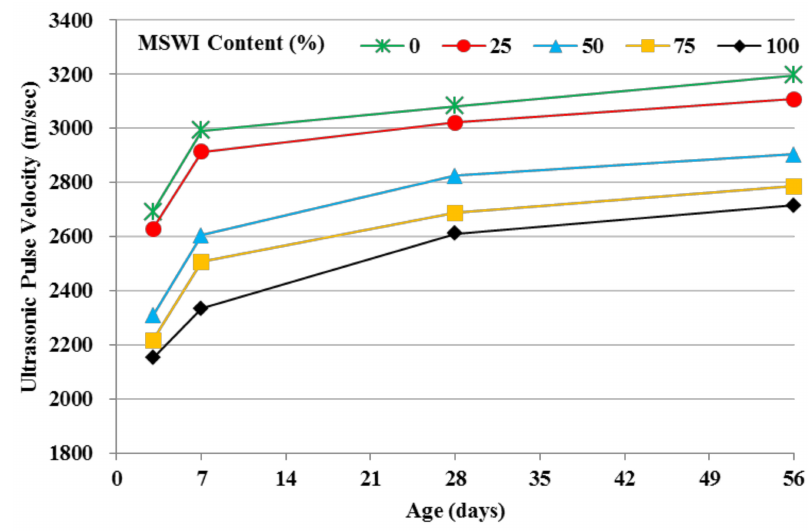
Figure 5. Effect of MSWI content on ultrasonic pulse velocity.